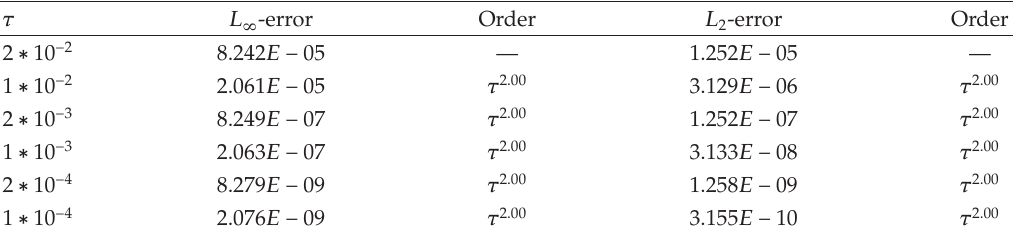
Table 3: Convergence rates at t (cid:7) 1 with μ (cid:7) 1, α (cid:7) β (cid:7) 1, γ (cid:7) 3, and n (cid:7)